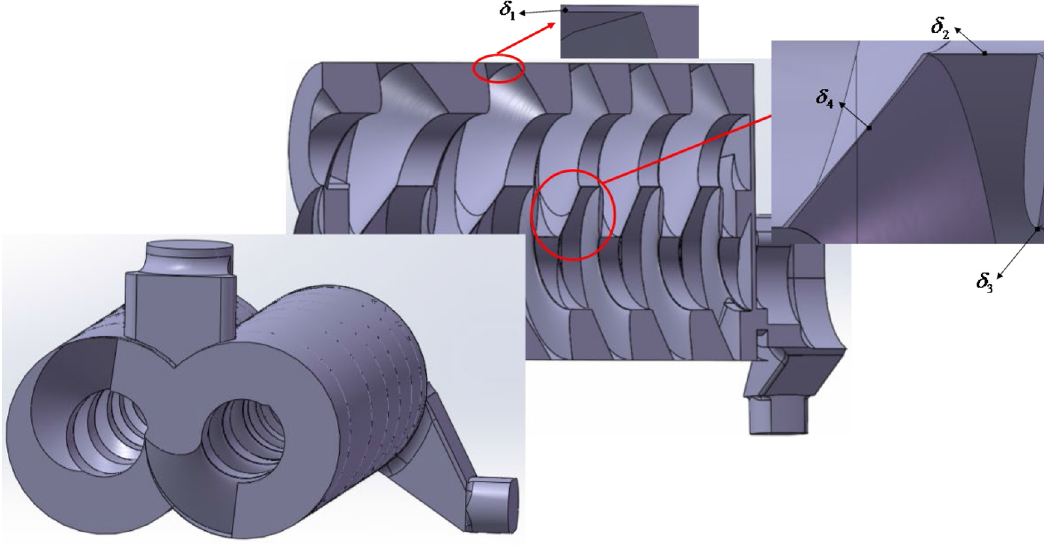
Fig. 9. Fluid domain of screw vacuum